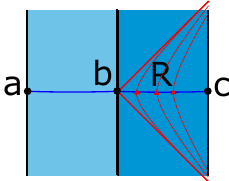
Figure 9 . Splitting an interval in two pieces using the modular